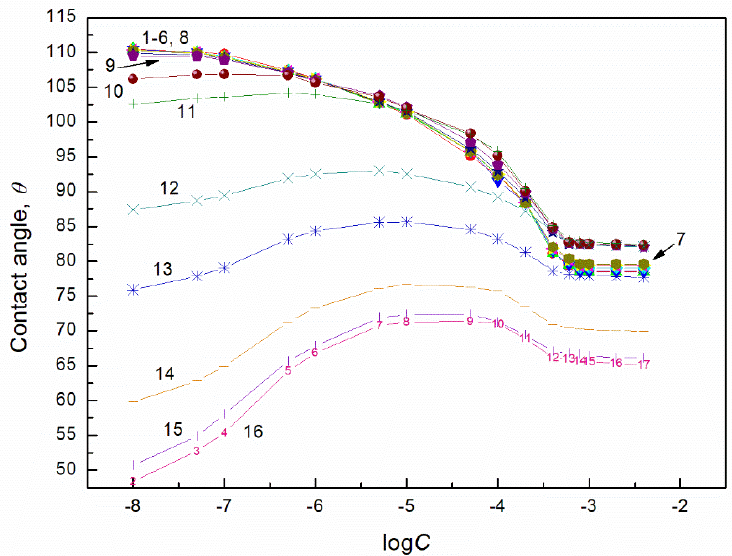
Figure 2. A plot of the contact angle ( 𝜃 ) of aqueous solution of TX165 + RL mixtures on the PTFE surface vs. the logarithm of the TX165 concentration ( 𝐶 ). Curves 1 – 16 correspond to the constant RL concentration equal to 0.0002, 0.0005, 0.00125, 0.003, 0.00625, 0.01, 0.02, 0.05, 0.1, 0.5, 1, 5, 10, 20, 30 and 40 mg/dm 3 , respectively.